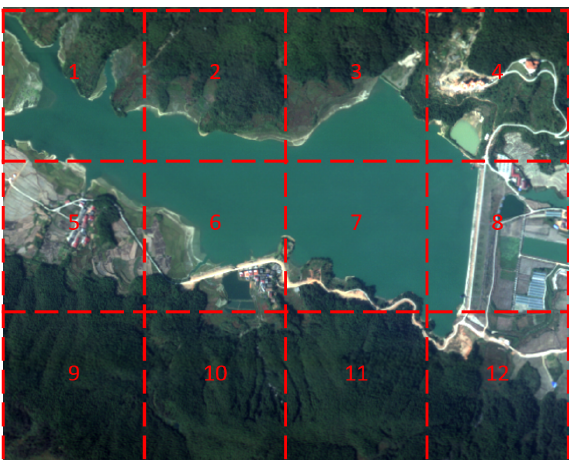
Figure 1. A remote sensing image with a resolution of 2048 × 1536 pixels is cropped into 12 small patches with a resolution of 512 × 512